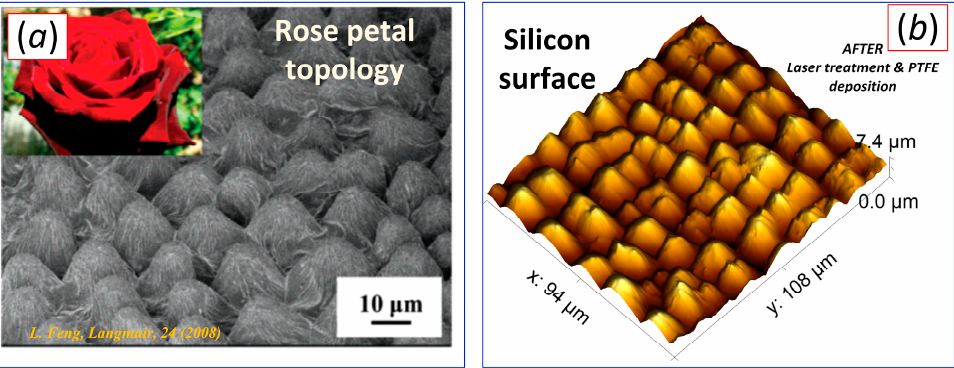
Figure 1. Comparison of the surface topology of the rose petal ( a ) (adapted from [15]) and samples synthesized in the present work ( b ).